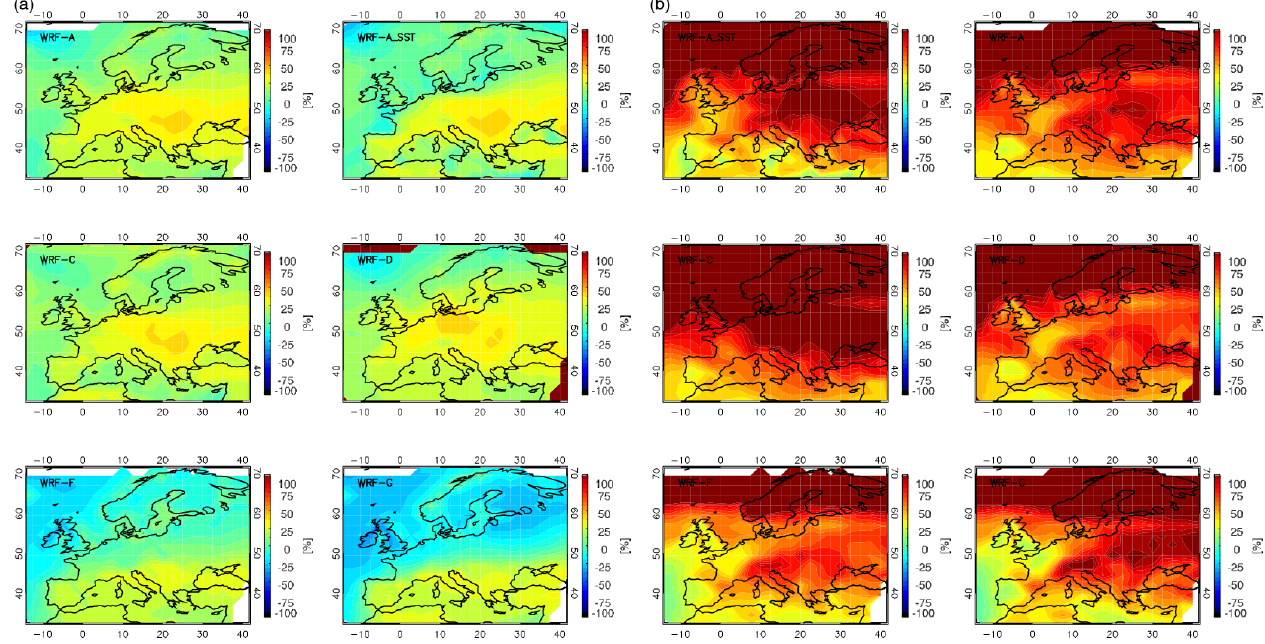
Figure 6. (a) Mean summer and (b) mean winter 1990–2008 downward surface shortwave radiation bias (WRF-ISCCP).